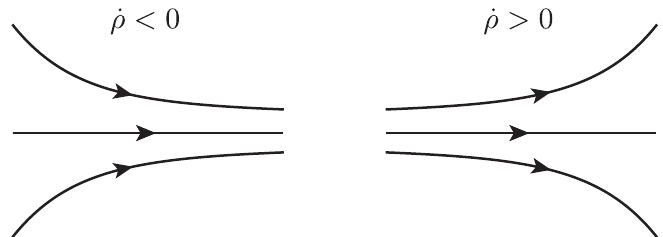
Figure 3. Schematic of the trajectory divergence rate: Where ˙ ρ < 0, trajectories are instantaneously converging; where ˙ ρ > 0 trajectories are instantaneously